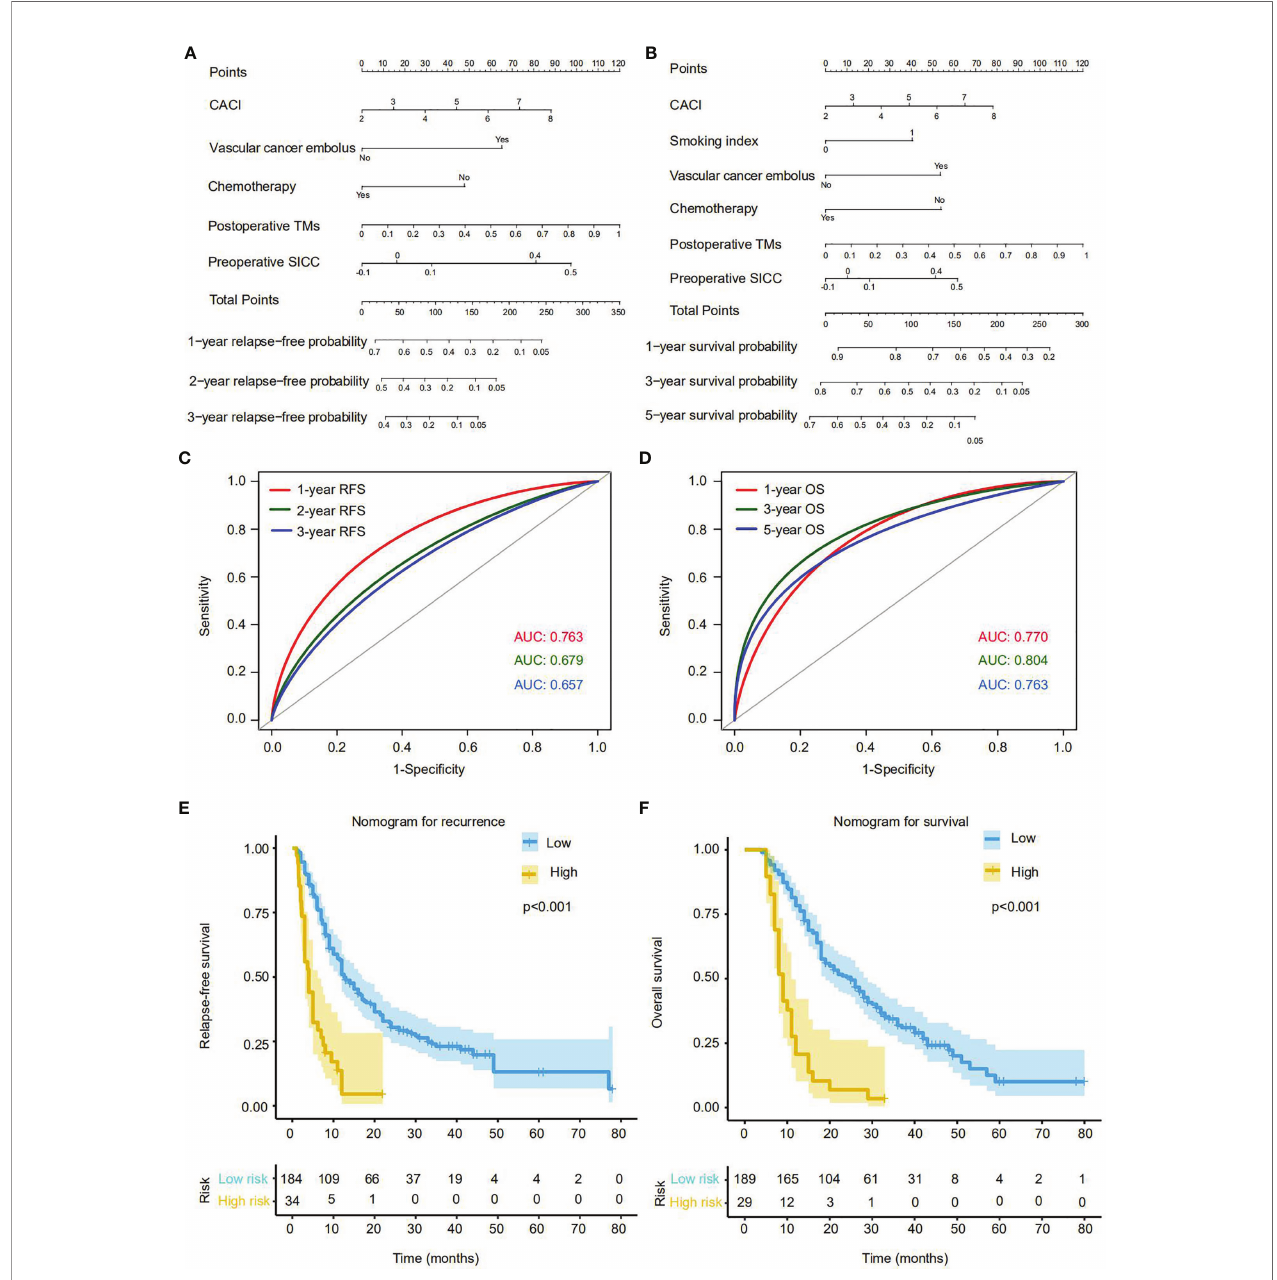
FIGURE 4 | Establishment and effectiveness evaluation of nomogramsfor predictingthe recurrence or OS rate ofPDAC patients with radical resection inthe trainingcohort. (A) Nomogram for predicting 1-, 2- and 3-year recurrence. (B) Nomogram for predicting 1-, 3-and 5-year OS. (C) The ROC curves andAUC values of the nomogram for 1-, 2- and 3-year recurrence predictions. (D) The ROC curves andAUC values of the nomogram for 1-, 3- and5-year OS predictions. (E,F) The Kaplan-Meier survival curves of RFS (E) and OS (F) for patients with low or high score according to the nomograms(cutoff recurrence = 191; cutoff survival = 185). Each cutoff value was calculated via